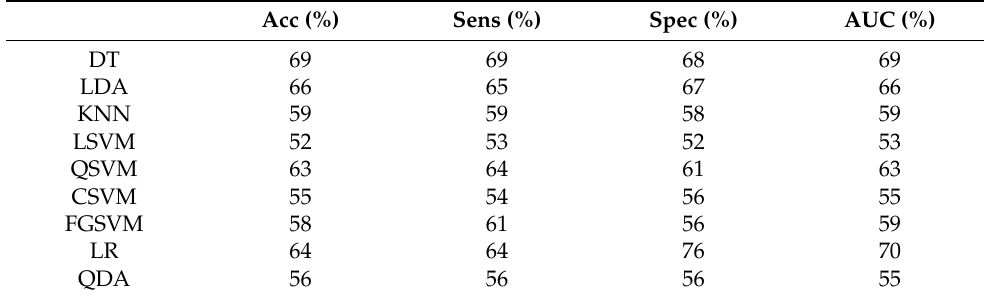
Table 7. Results for the raw data for Dataset 3.